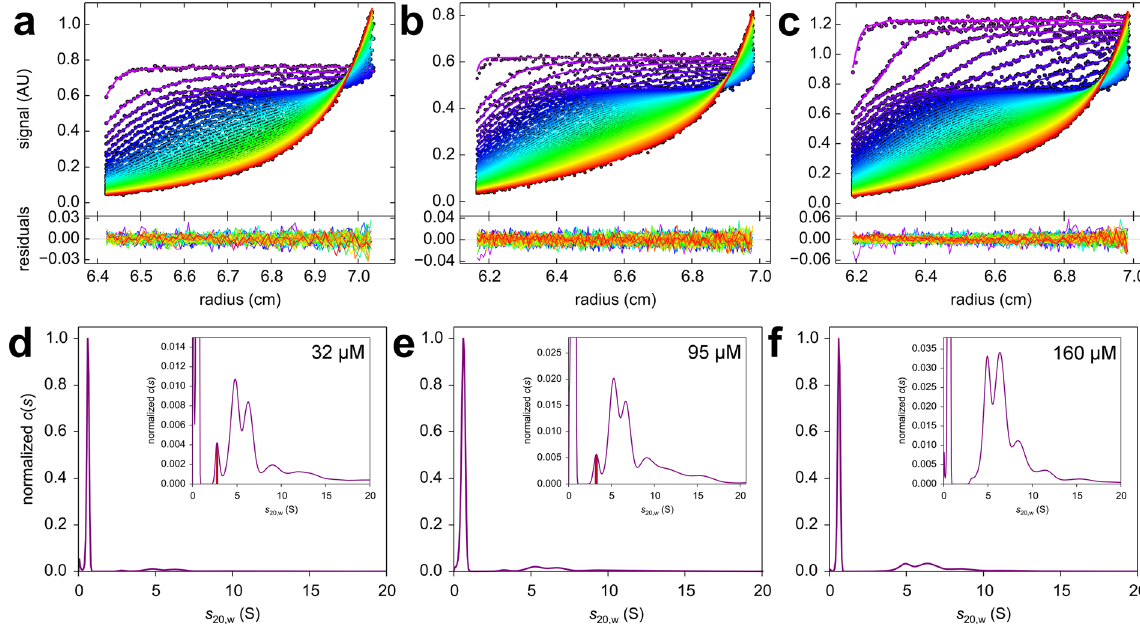
Figure 3. SV analysis at high A β 42 concentrations. Measured data overlaid with fit data and corresponding residuals are shown for 32 μ M ( a ), 95 μ M ( b ) and 160 μ M ( c ) A β 42. Below, c (s) analysis reveals the existence of a high fraction of larger oligomeric species aside from the monomer and a comparably low fraction of the 2 to 3 S species for 32 µ M ( d ), 95 µ M ( e ) and 160 µ M ( f ) A β 42. Sedimentation was performed at 60,000 rpm, 10 °C and monitored with absorbance detection at 280 nm. Normalization was performed according to peak height of the monomeric A β 42. The insets show the distributions with an expanded y scale.